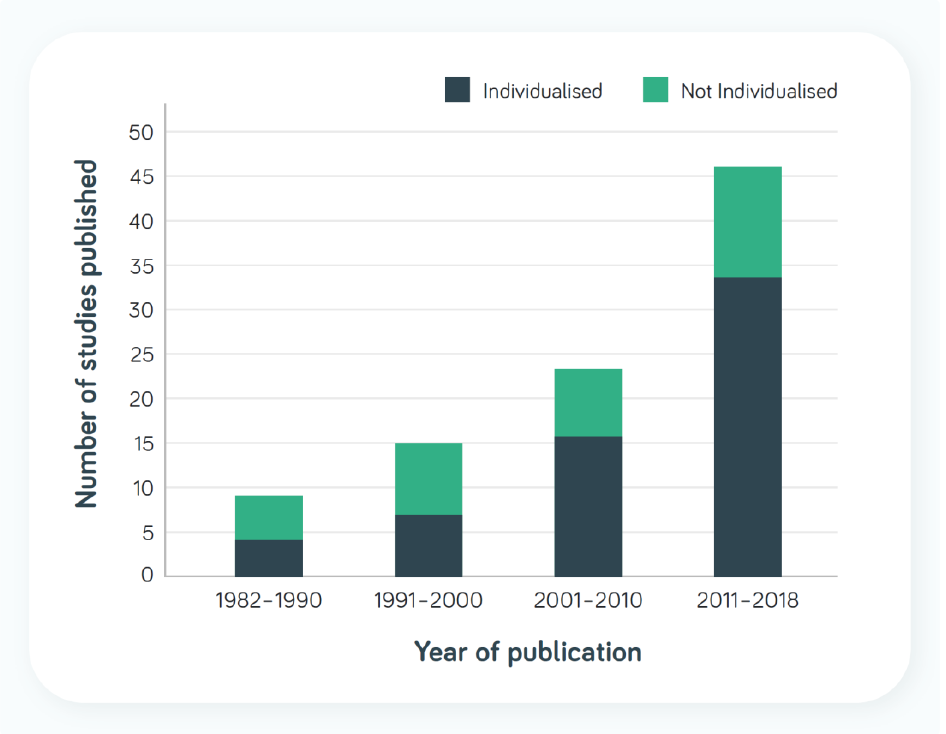
Figure 2. The number of studies reporting individualised or not-individualised interventions in- cluded in the Baldwin et al. review